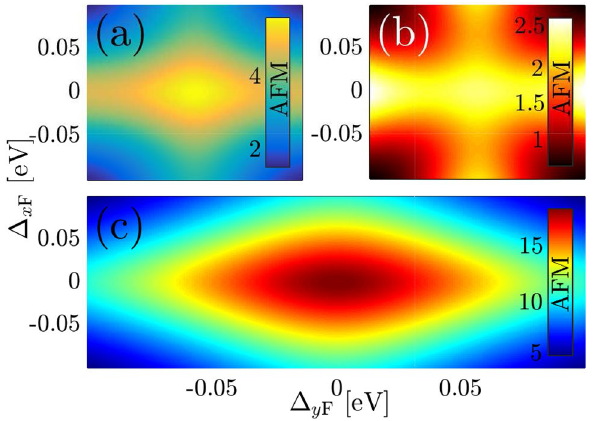
4 at R 30 Å , to the 10 − = × 0 , ( b ) ϕ 6 and ( c ) ϕ 4 R = π/ R = π/ =